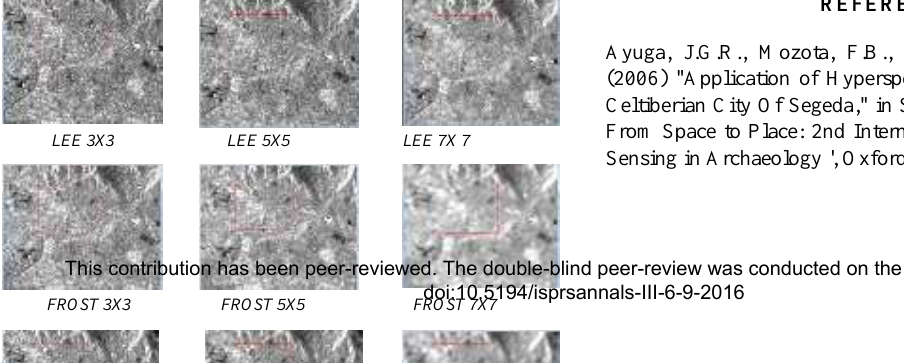
Figure 2 : Flowchart of data processing adopted in the study Image filtering is then applied to the pre-processed image, where the map enhancement of the entire study area is produced. The filtering technique had been applied to radar imagery such Lee, Frost and Gamma MAP filter in main processing stage. The advantage of adaptive filtering is their accuracy in estimate the backscattering coefficient inside homogenous (stationary) area while preserving edge and texture structure in non-stationary scenes. The performance of this proposed filter is evaluated and compared the pixel intensity values such as enhancement of the images by using Research System tool; ENVI 4.8 as a method in RADARSAT digital images processing. Various window sizes and six of iterations 3 × 3, 5 × 5 and 7 x 7 window sizes are used in order to fully understand the effects imposed by various window sizes and different number of iterations of each filter.